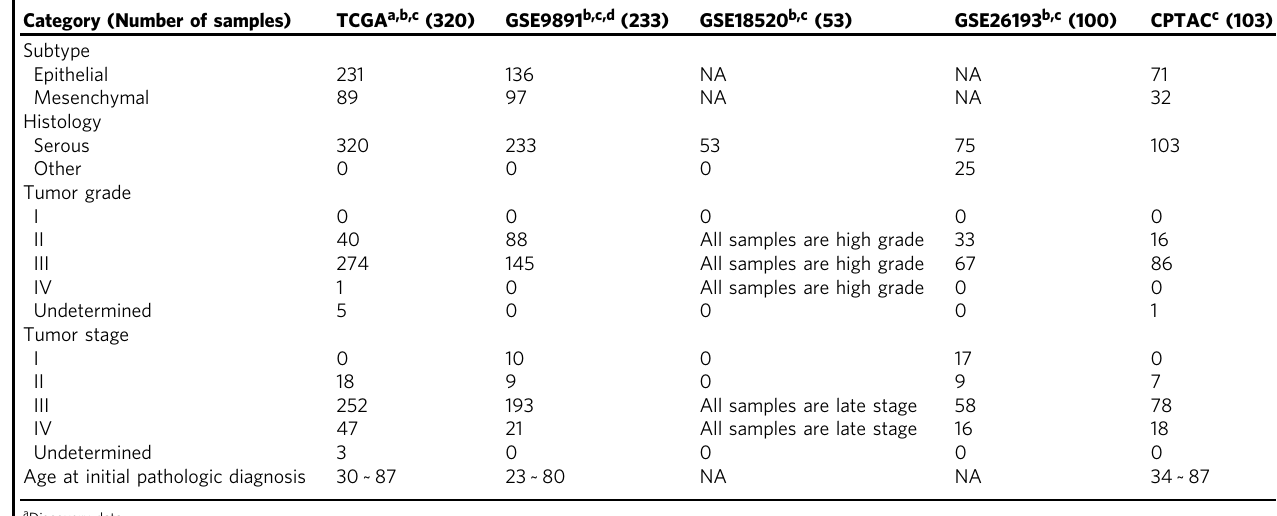
Table 1 Demographics and clinical information of ovarian cancer patient cohorts Category (Number of samples)